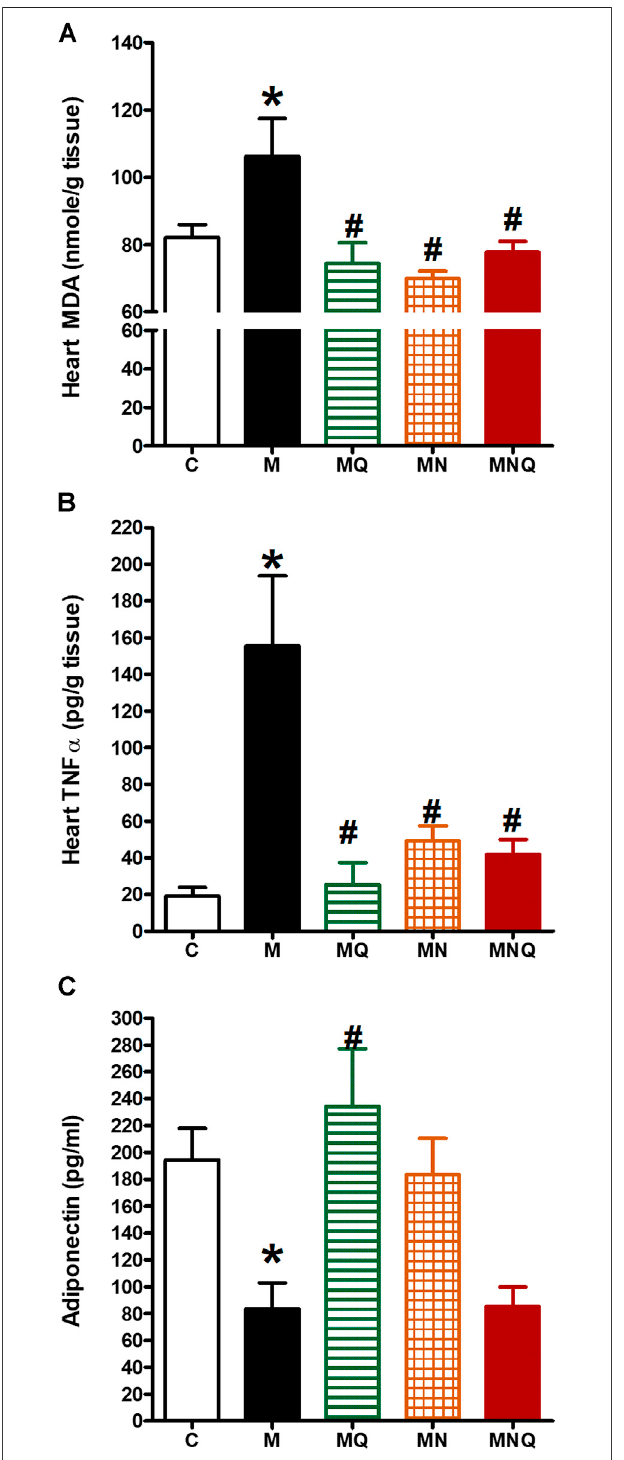
FIGURE 5 | Effect of oral administration of standard quercetin suspension (MQ), plain nano-pharmaceutical formulation (MN) and the quercetin loaded nano-pharmaceutical formulation (MNQ) both at 83 μ mol/kg/day on heart MDA (A) , heart TNF- α (B) and serum adiponectin (C) in metabolic syndrome (M) induced by feeding rats a high